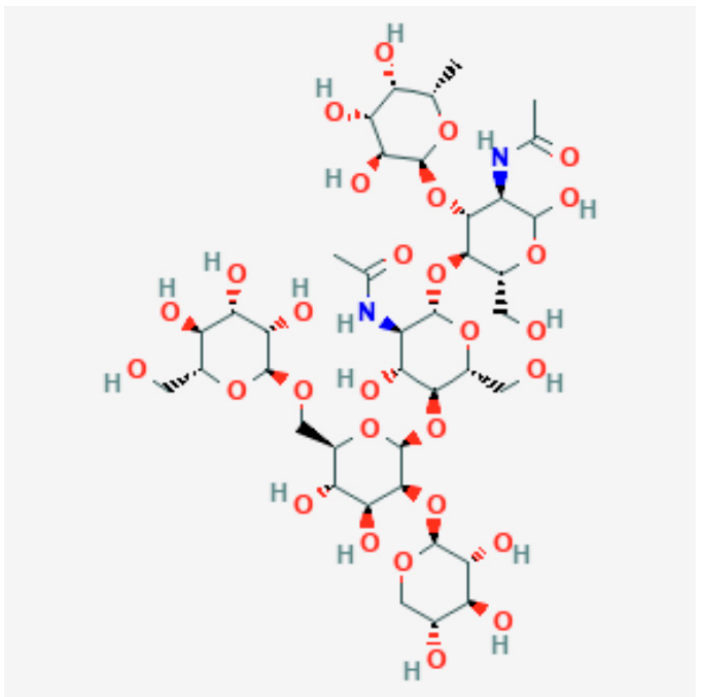
Figure 1. Chemical structure of bromelain. National Center for Biotechnology Information (2022). PubChem Compound Summary for CID 74981710, Bromelain. Retrieved 30 September 2022 from